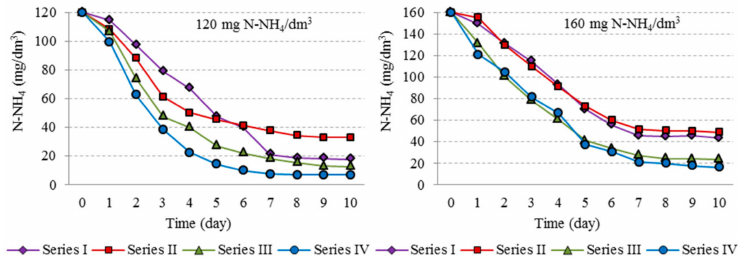
Figure 2. The changes of concentration of ammonium nitrogen in the cultivation medium depending on the variants and series of